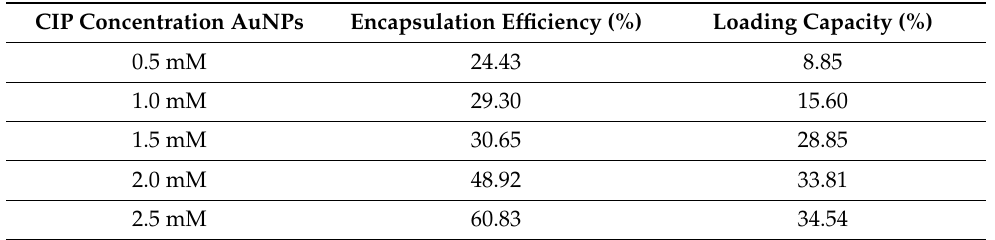
Table 1. Encapsulation efficiency (%) and loading capacity (%) of CIP onto the AuNPs at varying CIP